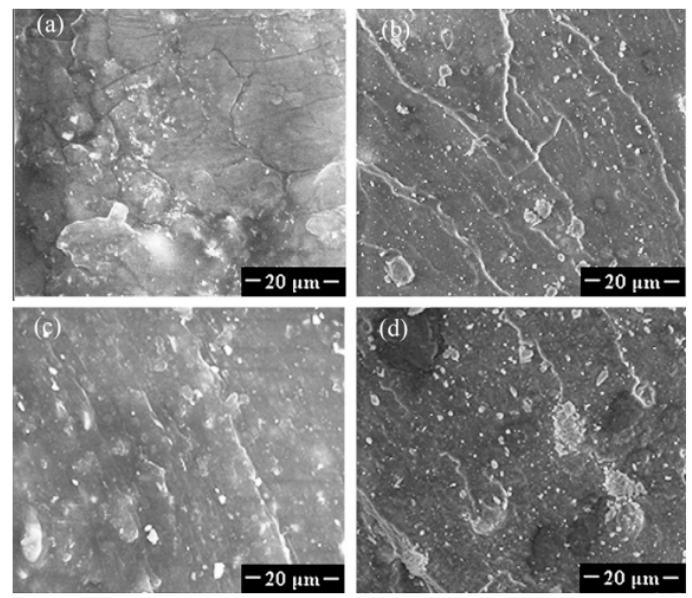
Figure 25. Tensile fractured surface of the compounds of Figure 24: ( a ) NR-PBR (100), ( b ) NR- PBR/RTR (80/20), ( c ) NR-PBR/RTR (60/40) and ( d ) NR-PBR/RTR (40/60) (reproduced with permission (80 / 20), ( c ) NR-PBR / RTR (60 / 40) and ( d ) NR-PBR / RTR (40 / 60) (reproduced with permission from [121]). from [121]).